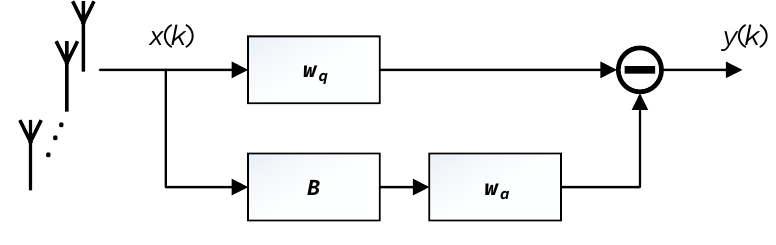
Figure 1. The framework of the GSC